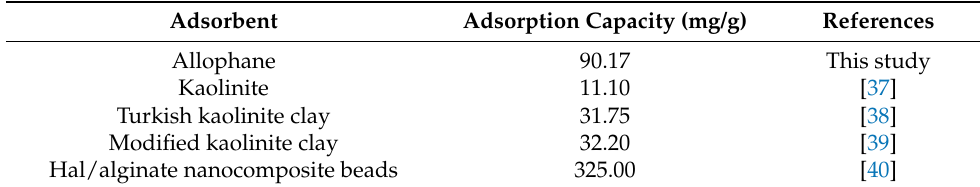
Table 3. Adsorption capacity of various clay materials towards